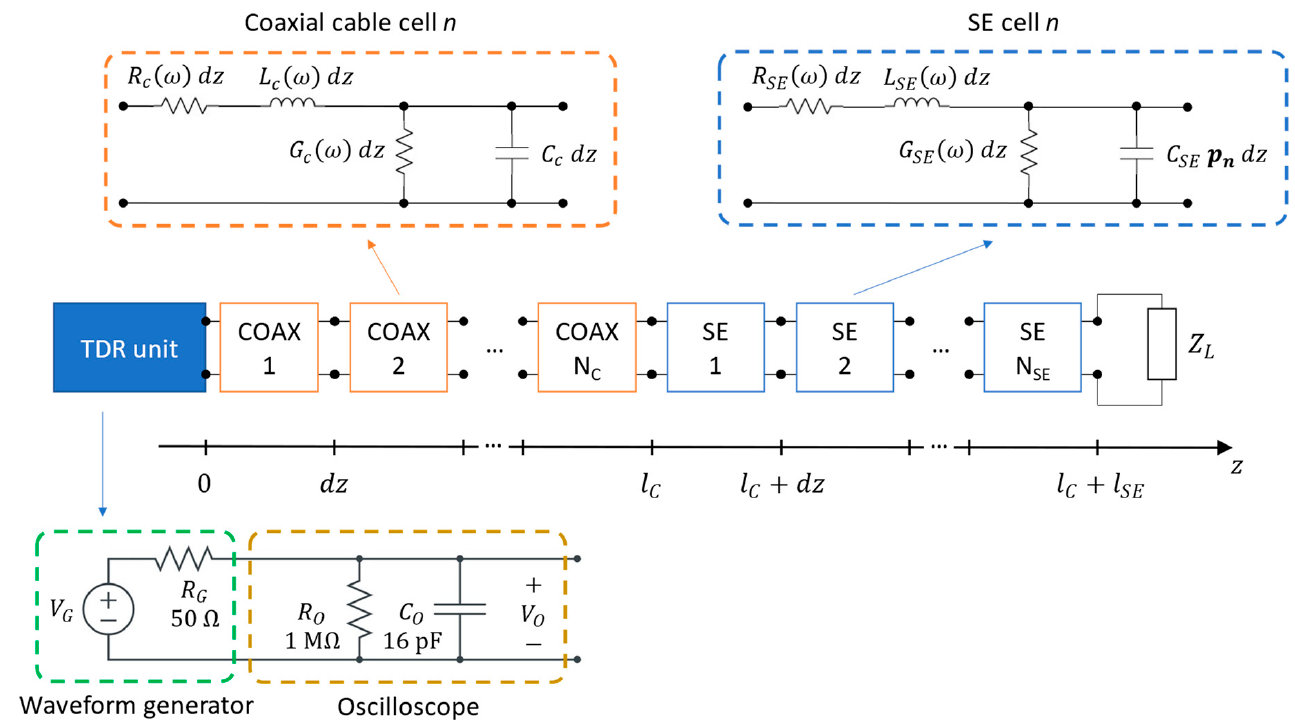
Figure 5. Model of the measurement system.